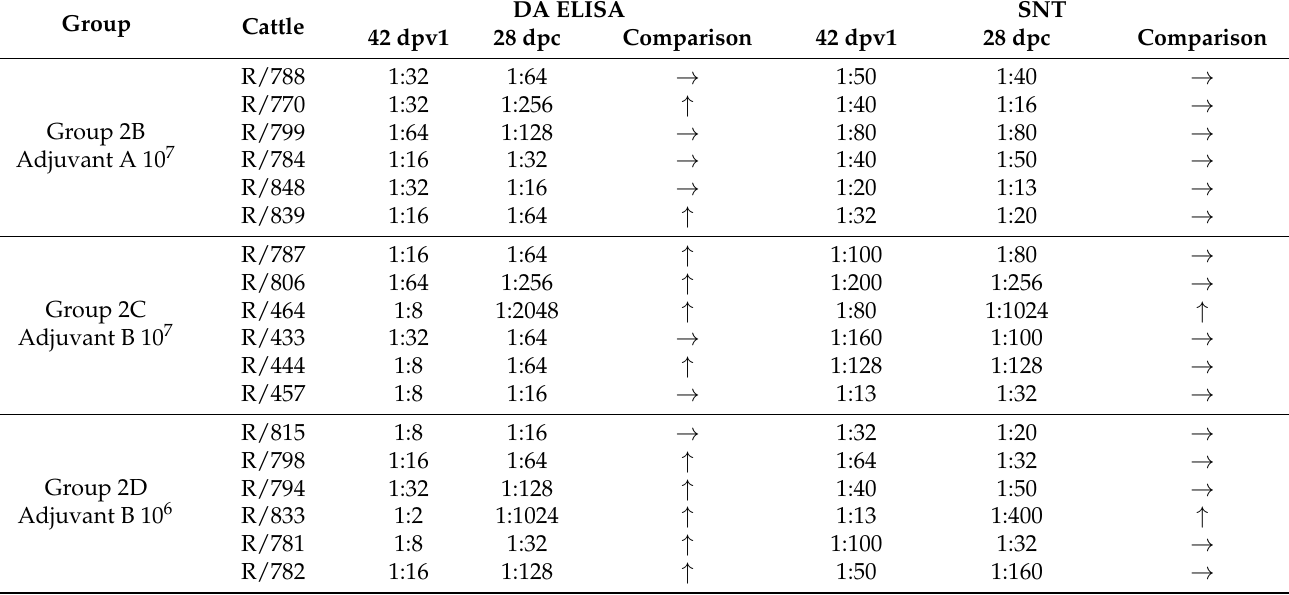
Table 4. Comparison of the ELISA titer and SNT titer of the sera taken at 42 dpv ( ˆ = 0 dpc) and 28 dpc during the vaccine- efficacy study. → displays difference of titers ≤ one log 2 , ↑ means increase of titer for more than one log 2 , samples with a SNT titer ≥ 1:20 are defined